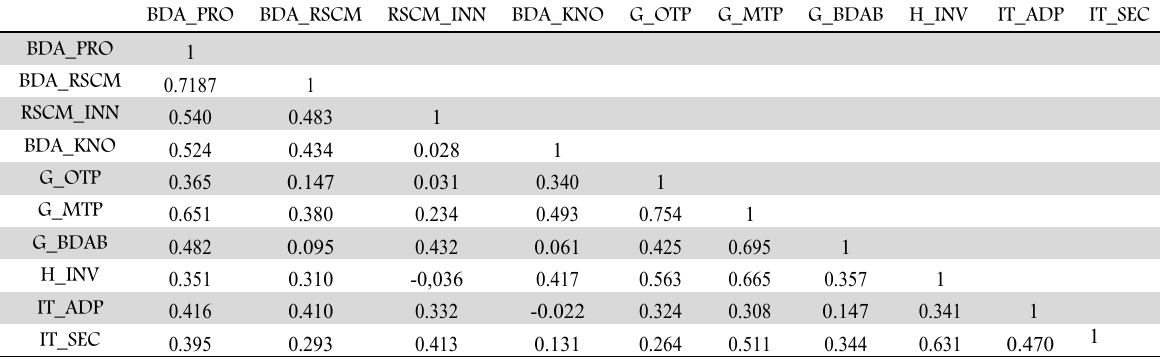
Pearson’s correlation